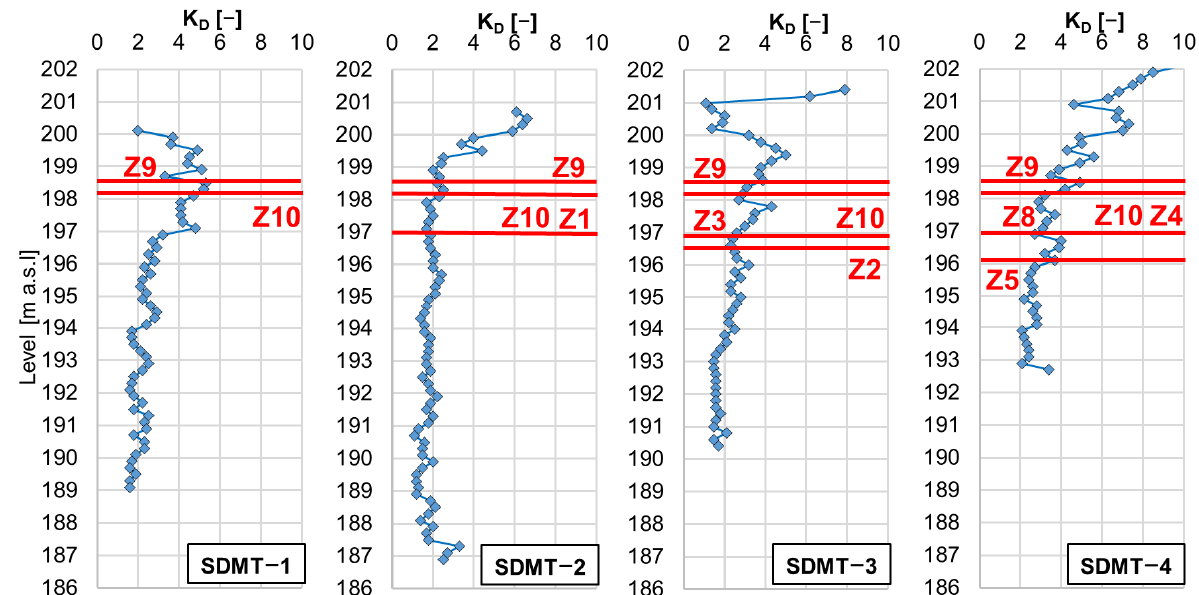
Figure 6. K D and M DMT distribution with depth (red line—foundation level).